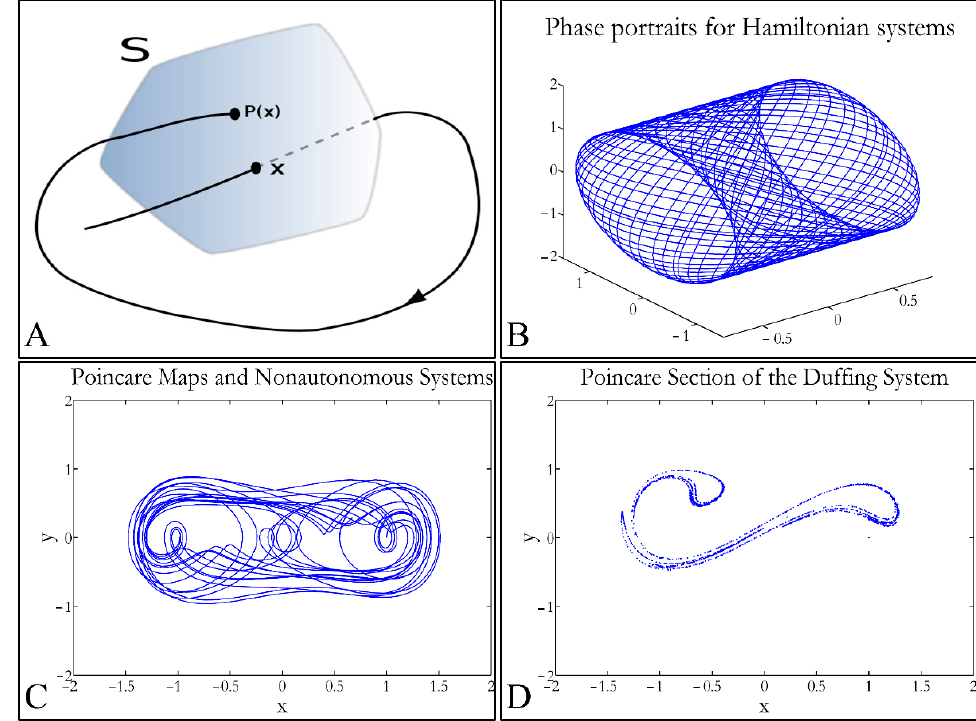
Figure 1 . Examples of Poincaré maps. A trajectory intersects a plane at points x and P ( x ), where it is x = P ( x ) ( A ) (reproduced from https://en.wikipedia.org/wiki/Poincar%C3%A9_map, accessed on 24 May 2021). The phase portrait of a Hamiltonian function ( B ), with the respective Poincaré map ( C ), as well as the Poincaré map of a Duffing system ( D ) are presented.